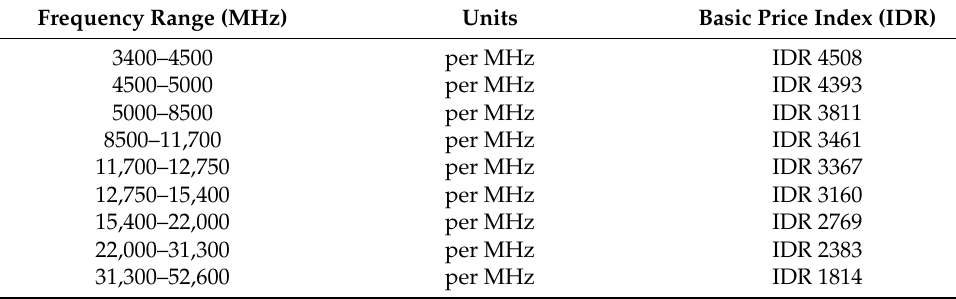
Table 4. The Indonesian basic price index value (I) for radio frequency bands [2].